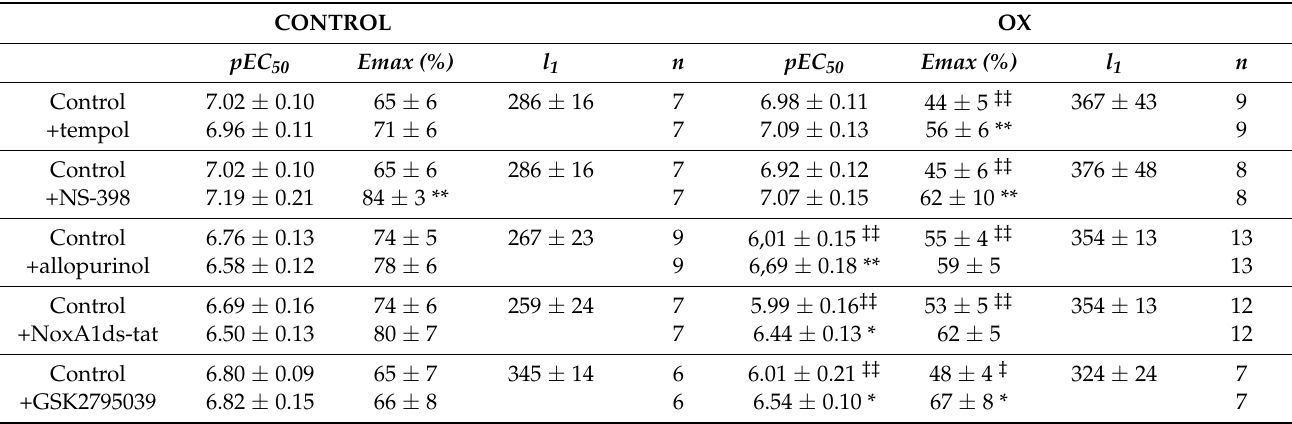
Table 2. Effects of the SOD mimetic tempol (30 µ M), the COX-2 inhibitor NS-398 (1 µ M), the xanthine oxidase inhibitor allopurinol (10 µ M), the Nox1 inhibitor NoxA1ds-tat (0.1 µ M) and the Nox2